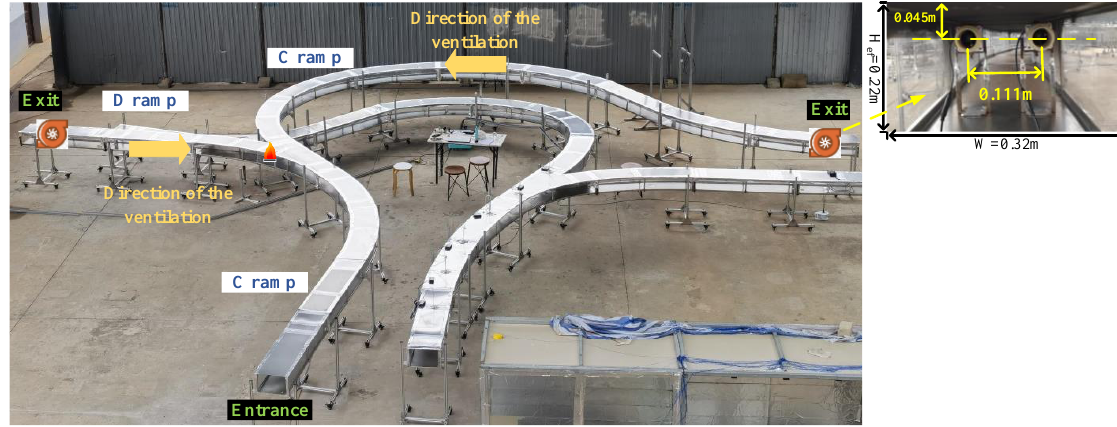
Figure 1. Model-scale underground interconnected tunnel.